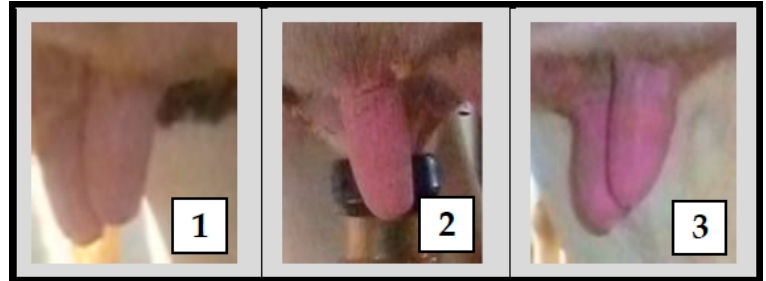
Figure 2. An example of classification of teats after the cluster removal. The classification was based on the color change of the teat and it used a color-change scale that had the following meanings: ( 1 ) for a normal pink-colored teat; ( 2 ) when the whole teat, or a part of it, was red-colored; and ( 3 ) if the whole teat, or a part of it, was blue or